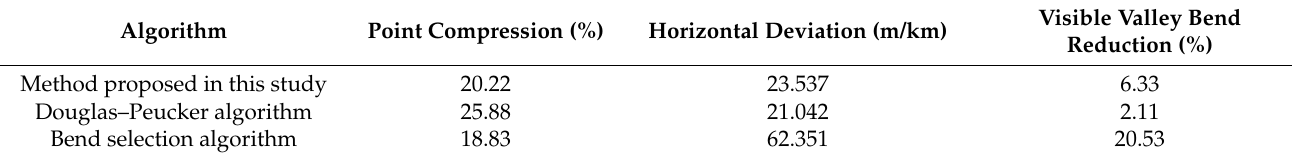
Table 1. Evaluation of contour line simplification results.